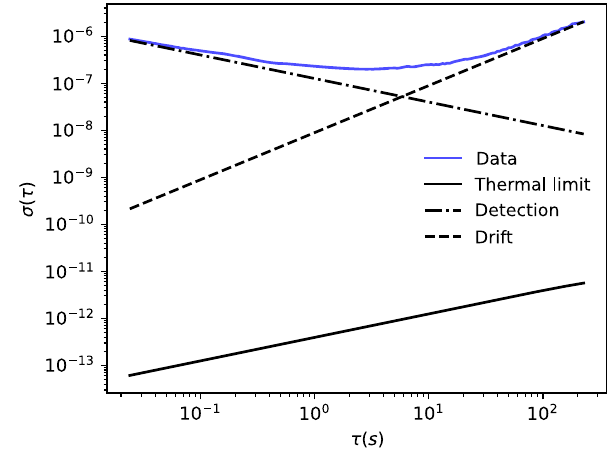
FIG. 14. Frequency stability of perimeter modes. The meas- urement result of Allan deviation of a 1 mm square-shaped 0 . 2 is plotted in blue dots. sample with w 0 ¼ 200 nm and r l ¼ The dash-dotted line shows the calculated detection limit based on the measurement SNR, and the dashed line is the fit to the linear frequency drift in the long time limit. The fit yields a drift rate D ∼ 10 − 8 s − 1 , which varies among different samples. The theoretical thermal mechanical limit is plotted in black line, which is many orders of magnitude below the measured Allan deviation, due to the exceptionally high quality factor. The scaling is reversed from the usual τ − 1 = 2 to τ 1 = 2 because we are in the limit where the mechanics lifetime is longer than the measurement time τ < 1 = Γ m